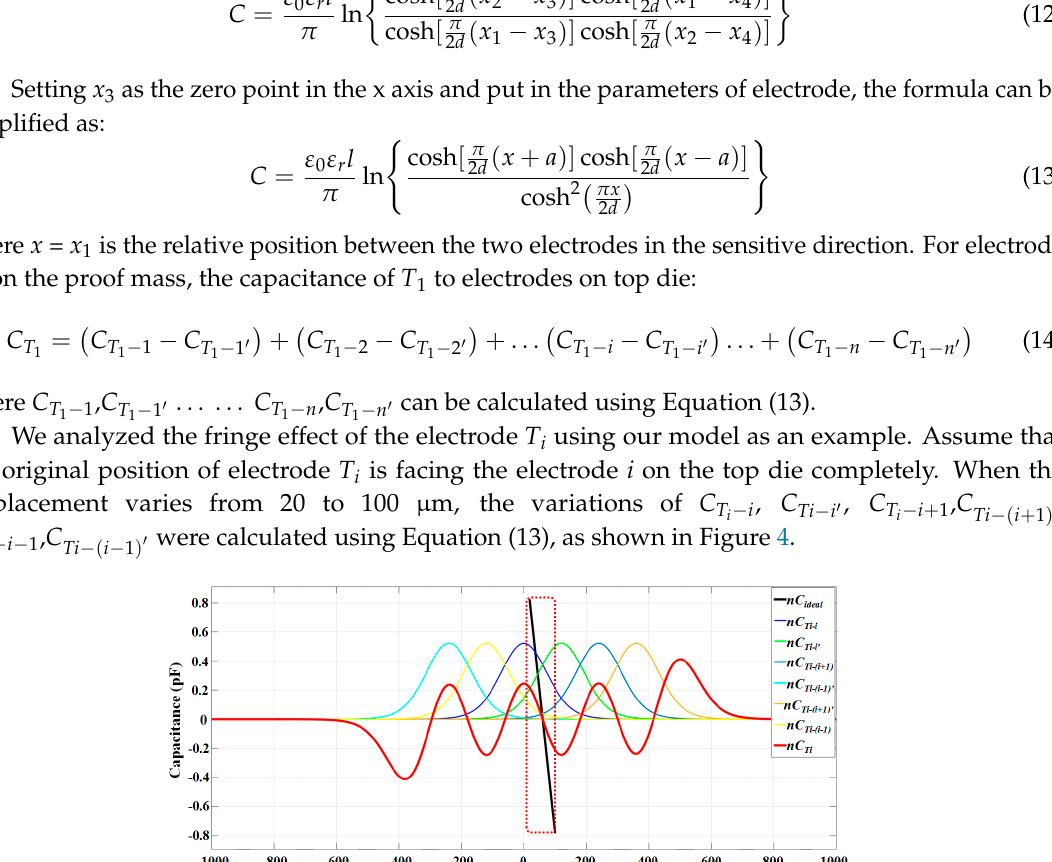
C (red line) i T (red line) is the theoretical i , C Ti − i (cid:48) , C T , C , Ti − ( i + 1 ) (cid:48) i − i i − i + 1